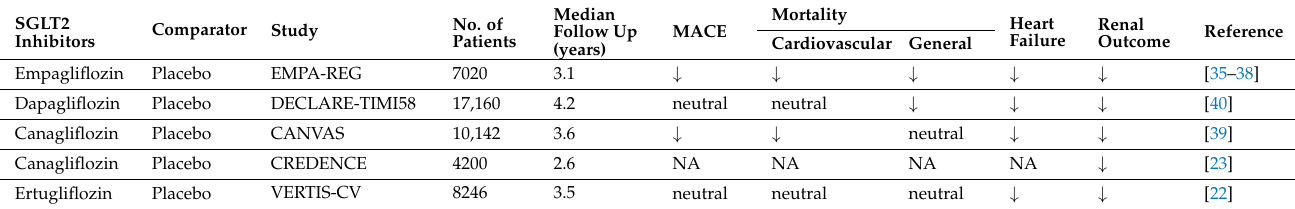
Table 1. Clinical trials of cardiovascular and renal outcomes of treatment with SGLT2